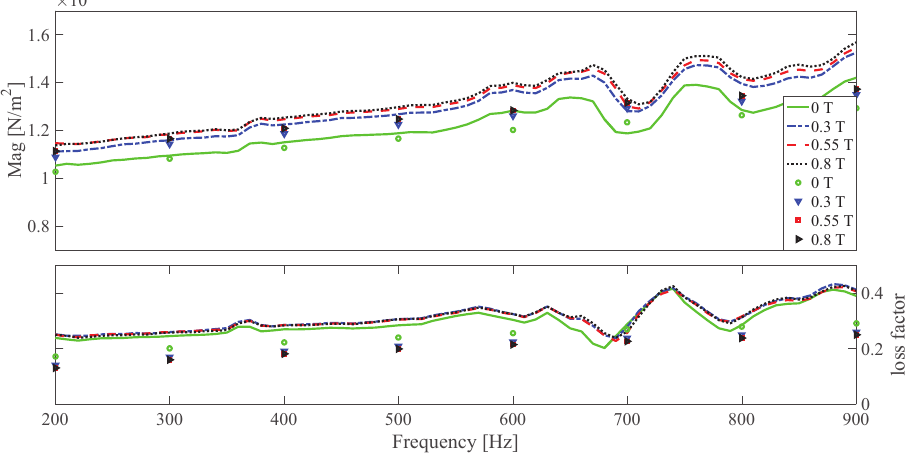
Figure 7. The magnitude and loss factor of the dynamic shear modulus versus frequency at 0.0015 strain amplitude and 273K. Lines and symbols are the measurement and simulation results,